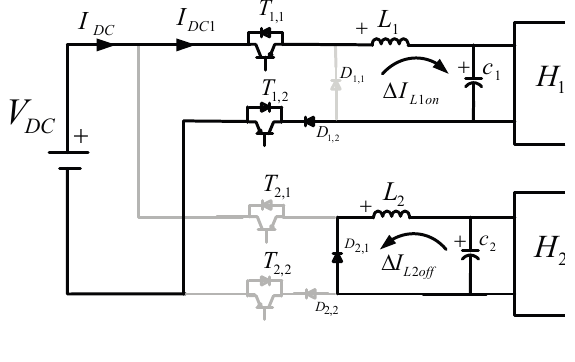
Figure 2. Topological state (ii), m 1 = 1, m 2 =